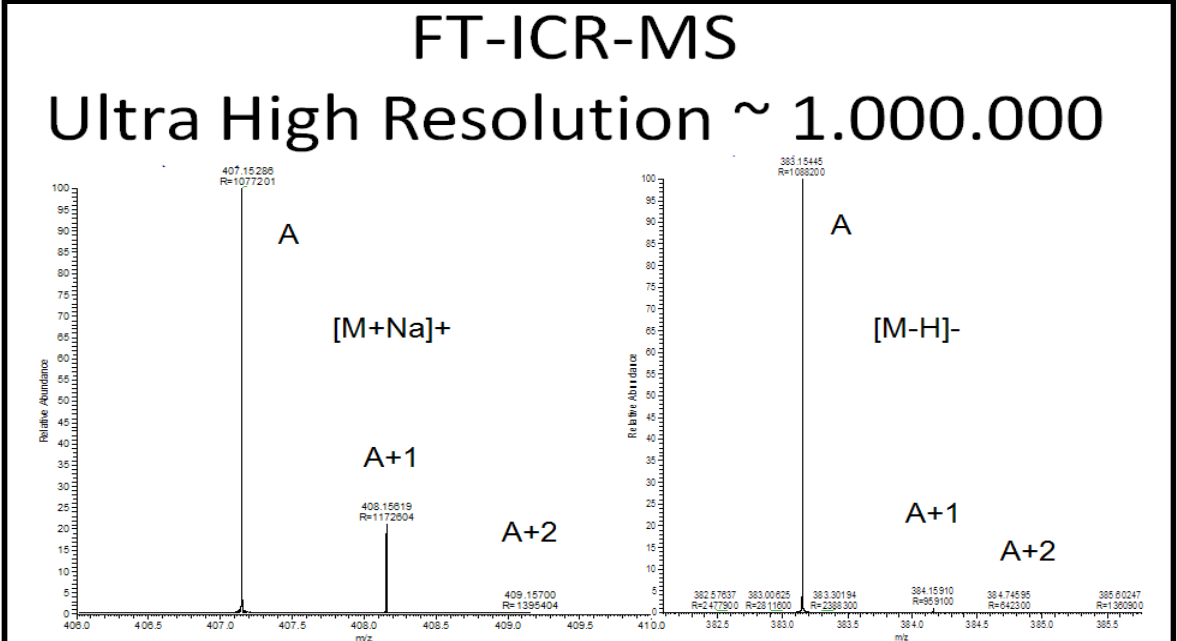
Figure 9. High-resolution spectra of a potential predictor, m/z 407.1527 at positive mode [M+Na] + and m/z 383.1545 at negative mode [M-H] − , illustrating isotopic pattern at 1,000,000 resolution using NanoMate nano ESI-LTQ FT Ultra